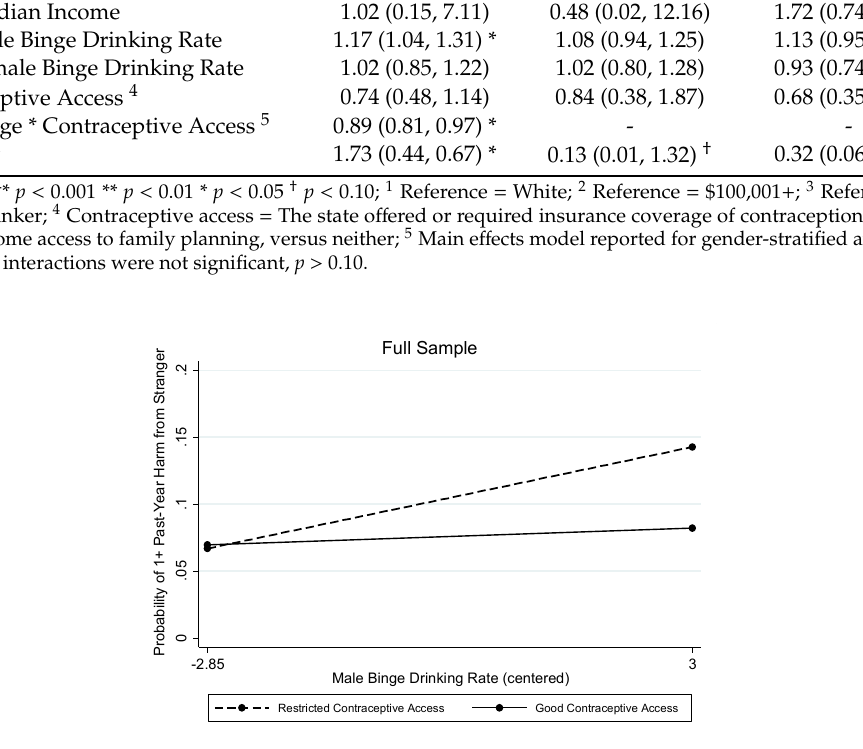
Figure 2. Interaction between male binge drinking rate and contraceptive access in relation to stranger-perpetrated harm in the full sample.